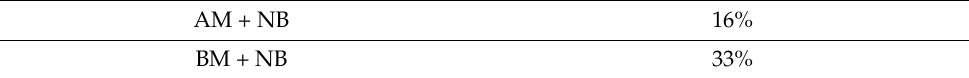
Table 4. Percentage (%) gain in bone level at 6 months ( n = 10 patients in each group). AM + NB 16% BM + NB 33% For sites treated with AM + NB, the average pocket probing depth, relative attachment level, and initial depth of the bone defect were 8.60 mm, 13.70 mm, and 7.76 mm,